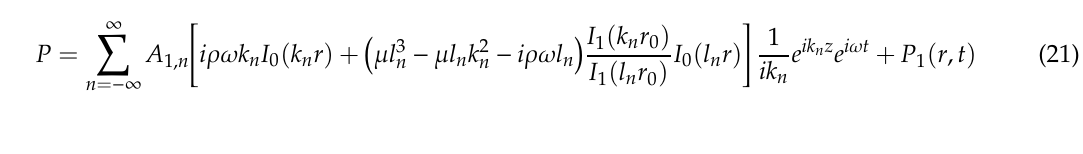
  1 03 2 n n ik z i t  1 0